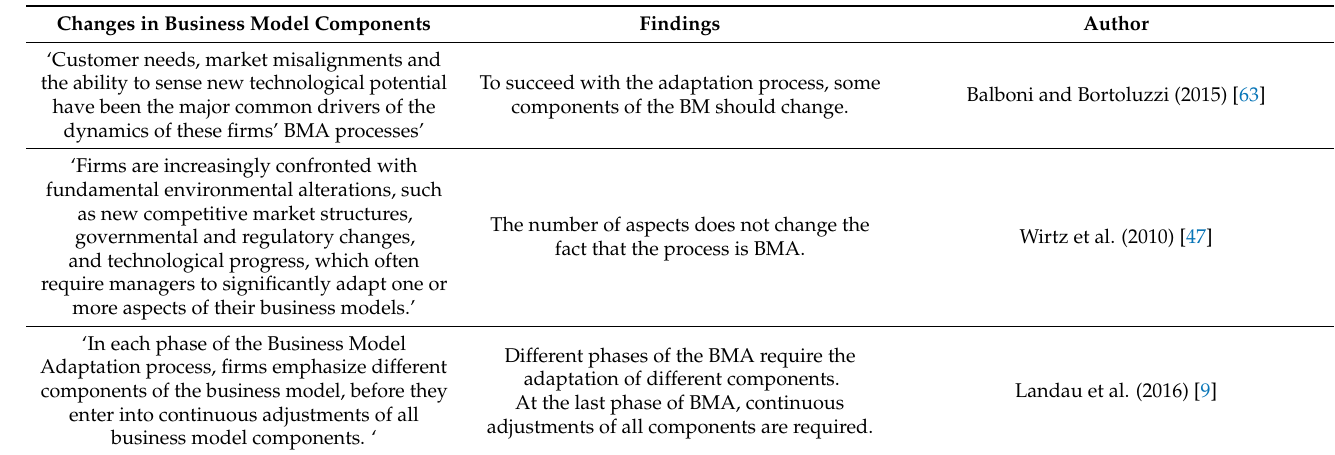
Table 9. Changes in the Business Model